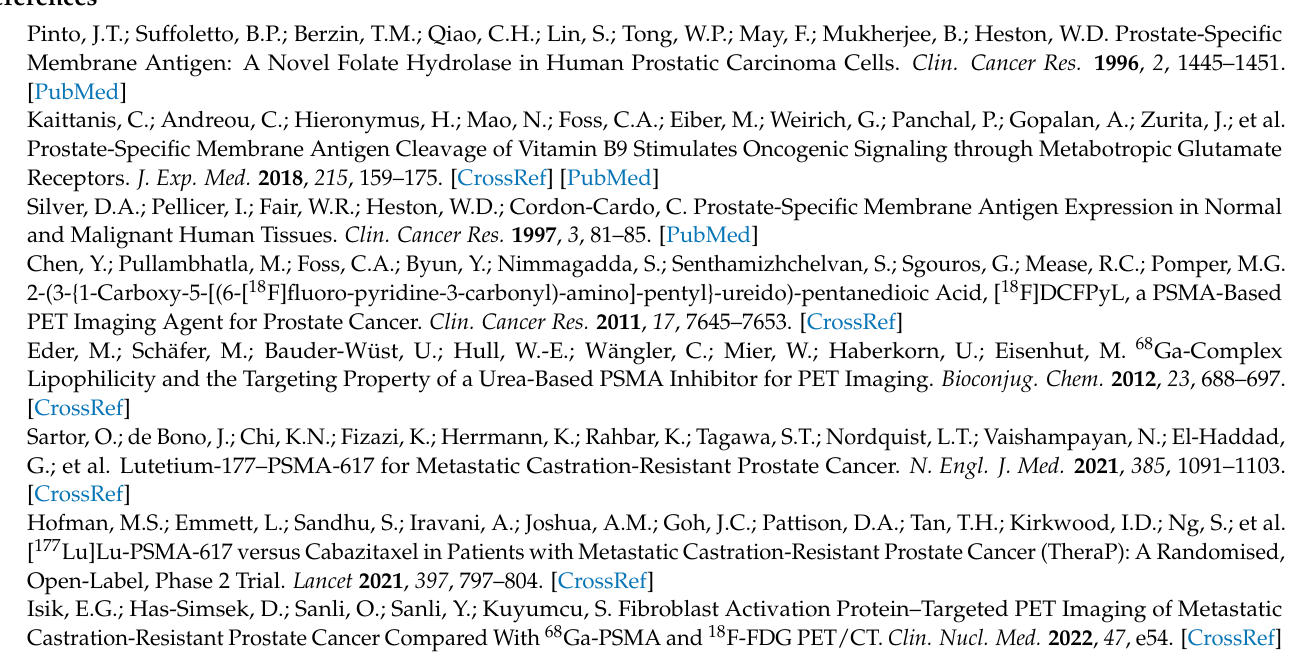
Table S3: HPLC conditions for the purification and quality control of 68 Ga-labeled tracers; Table S4: Biodistribution and uptake ratios of 68 Ga-labeled PSMA/FAP bispecific tracers, HTK03041 and FAPI-04 in LNCaP tumor-bearing mice; Table S5: Biodistribution and uptake ratios of 68 Ga- labeled PSMA/FAP bispecific tracers, HTK03041 and FAPI-04 in HEK293T:hFAP tumor-bearing mice